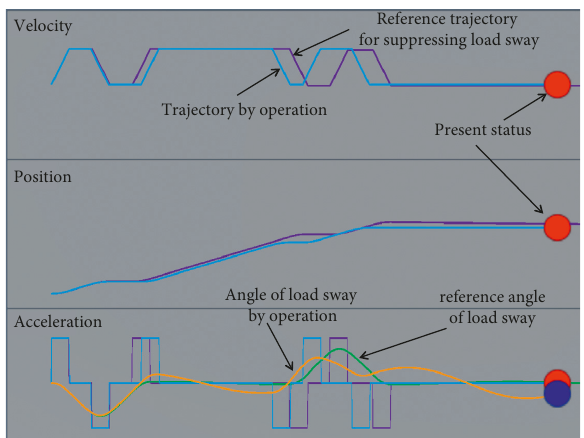
Figure 9: Monitor display with time-series graph in training for memorizing timings of operation.